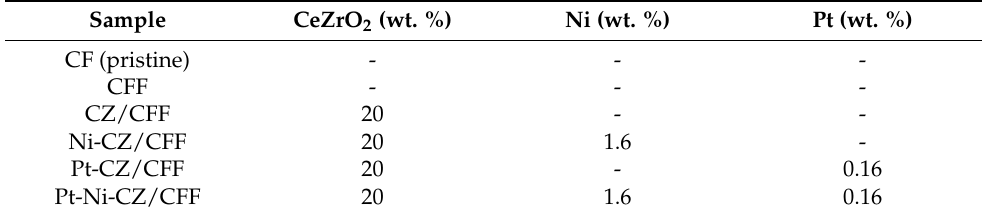
Table 4. The composition of prepared CFF-supported